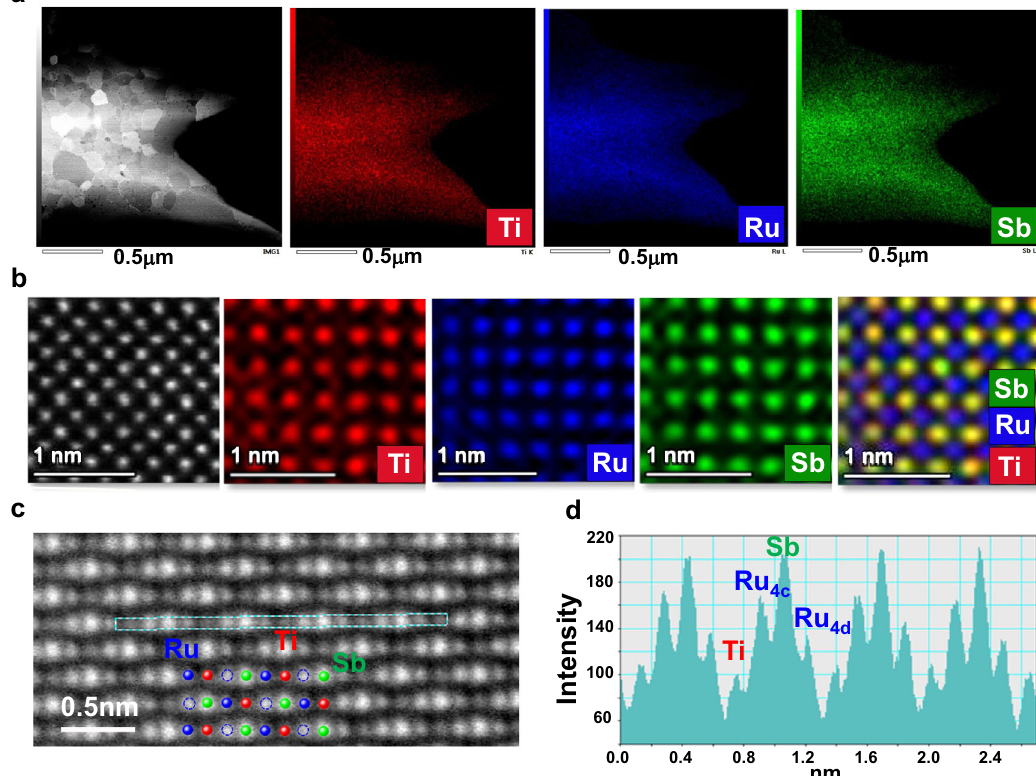
Fig. 2 Microscopic structures of TiRu 1.5 Sb. a Dark fi eld STEM image and corresponding EDS maps. b Atom-resolved HAADF image and corresponding EDS maps projected along the [100] direction. c Aberration correction high-resolution HAADF image along a [110] direction. d Intensity pro fi le across the horizontal line in ( c